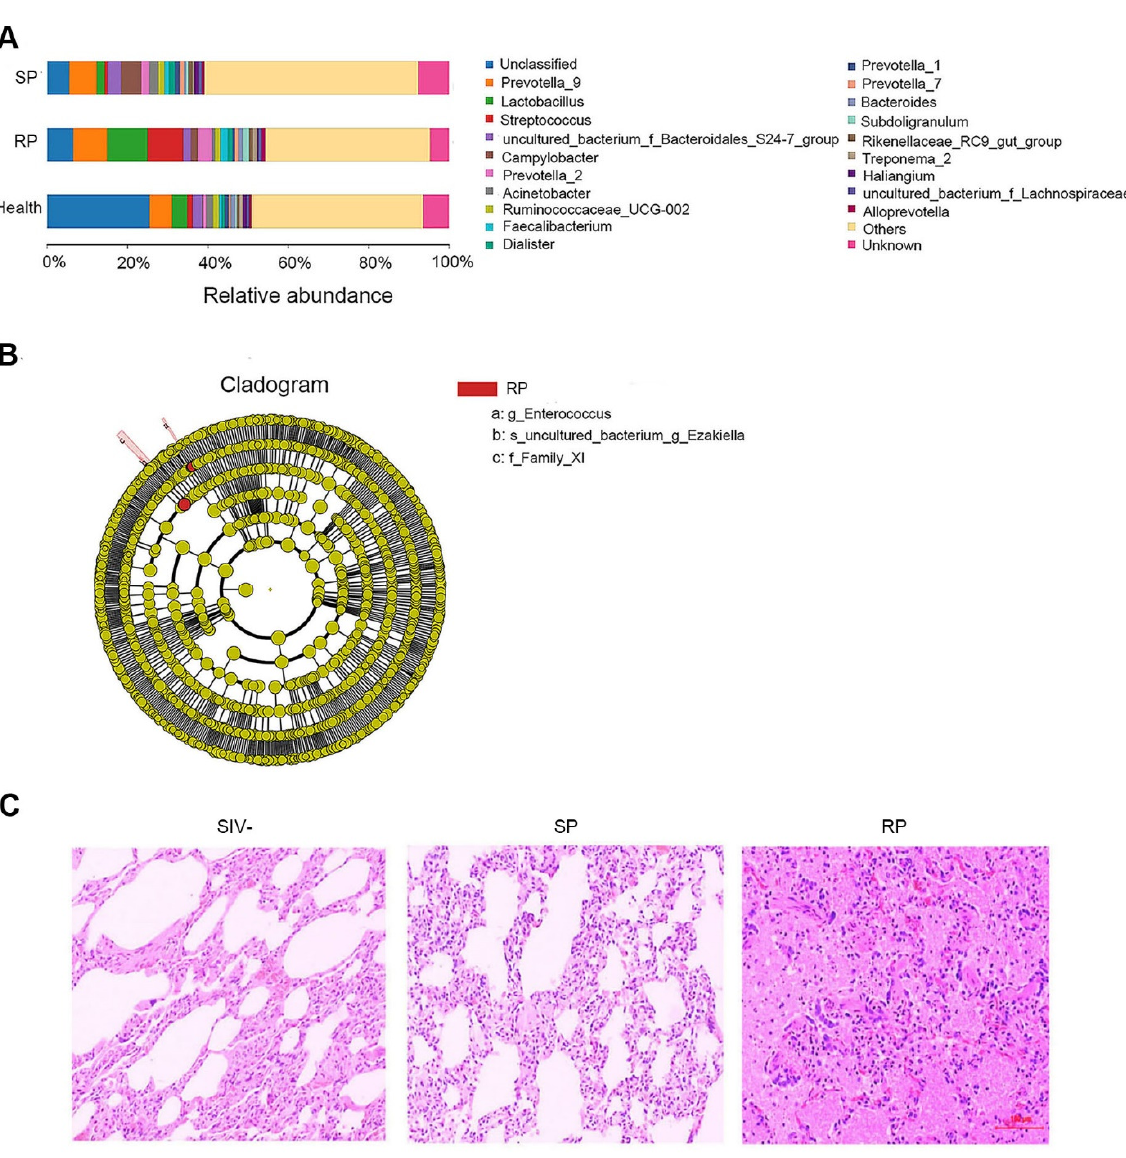
Figure 2. Changes in microbial flora in the lungs during primary infection with SIVmac239. ( A ) The relative abundance of flora in the lungs of the SP, RP, and healthy groups. The bar graph shows only the top 20 species at the abundance level and merges other species into “Others”. “Unknown” represents species that have not been taxonomically annotated, and the different colors represent different flora. ( B ) Cladogram from LEfSe analysis. The circles radiating from the inside to the outside represent the classification levels of the microbes from phylum to species (g: genus; s: species; f: family); each small circle at the different classification levels represents a classification at this level, and the diameter of the small circle is proportional to the relative abundance. Species without significant differences are uniformly colored yellow, and other species with significant differences are colored red. ( C ) HE staining of lungs. Representative figures were selected randomly. SP: n = 3, RP: n = 3, SIV-: n =